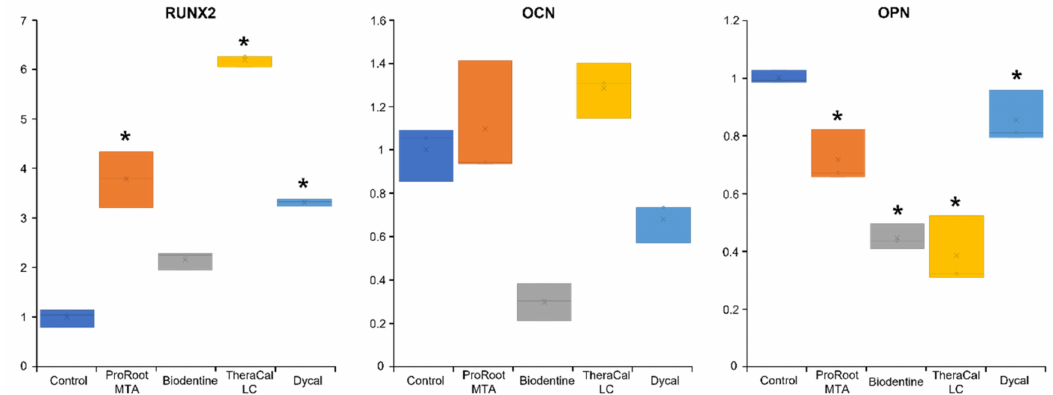
Figure 6. Relative expression levels of osteogenic genes, Runx2 , OCN , and OPN , in hDPSCs incubated for 9 days with various pulp capping materials. * Statistically significant difference between experimental and control groups.